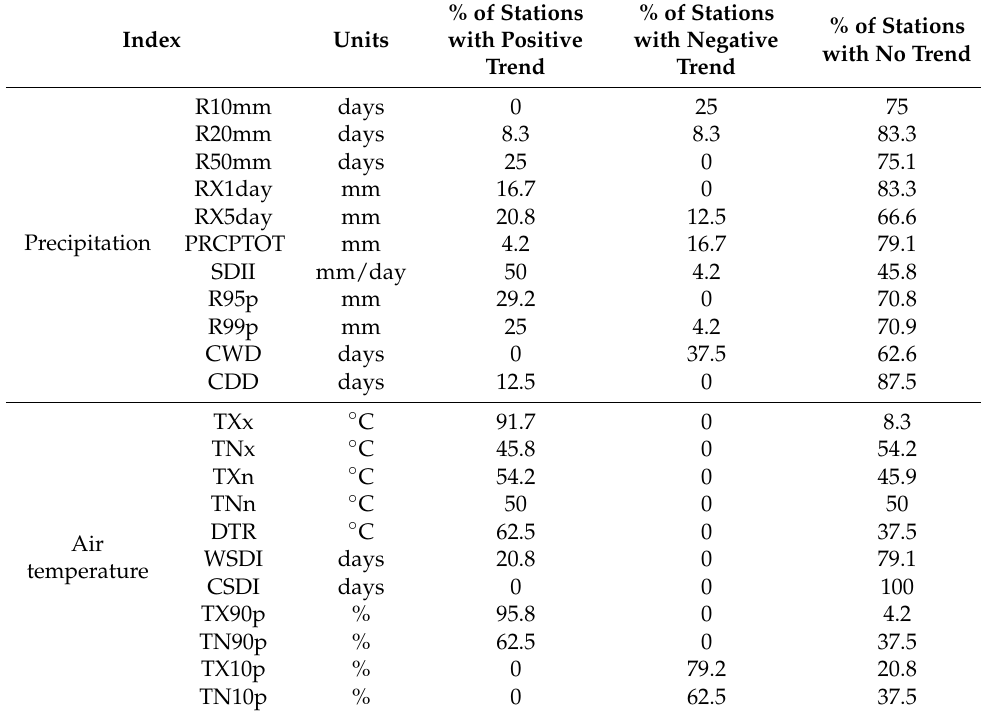
Table 3. The percentage of stations with significant positive or negative trends and no trend of the precipitation and air temperature climate extreme indices according to the Mann–Kendall test for the Midwest region of Brazil from 1979 to 2019. Index Units